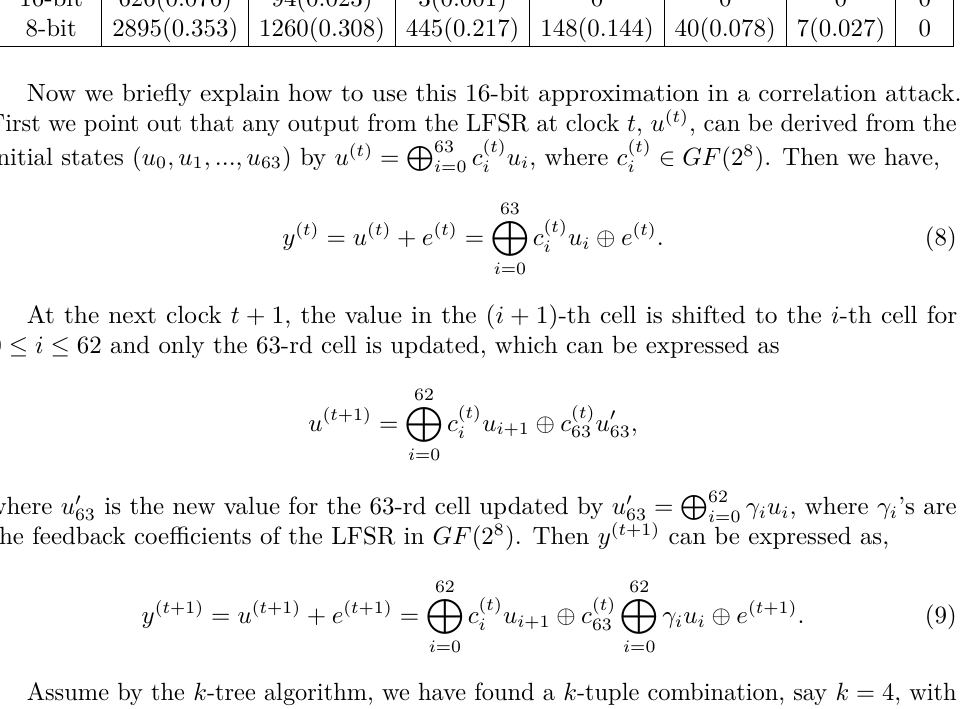
Table 1: Errors and error probabilities (in the brackets) under different lengths of samples Length 2 40 2 41 2 42 2 43 2 44 2 45 2 46 Samples 8192 4096 2048 1024 512 256 128 16-bit 626(0 . 076) 94(0 . 023) 3(0 . 001) 0 0 0 0 8-bit 2895(0 . 353) 1260(0 . 308) 445(0 . 217) 148(0 . 144) 40(0 . 078) 7(0 .